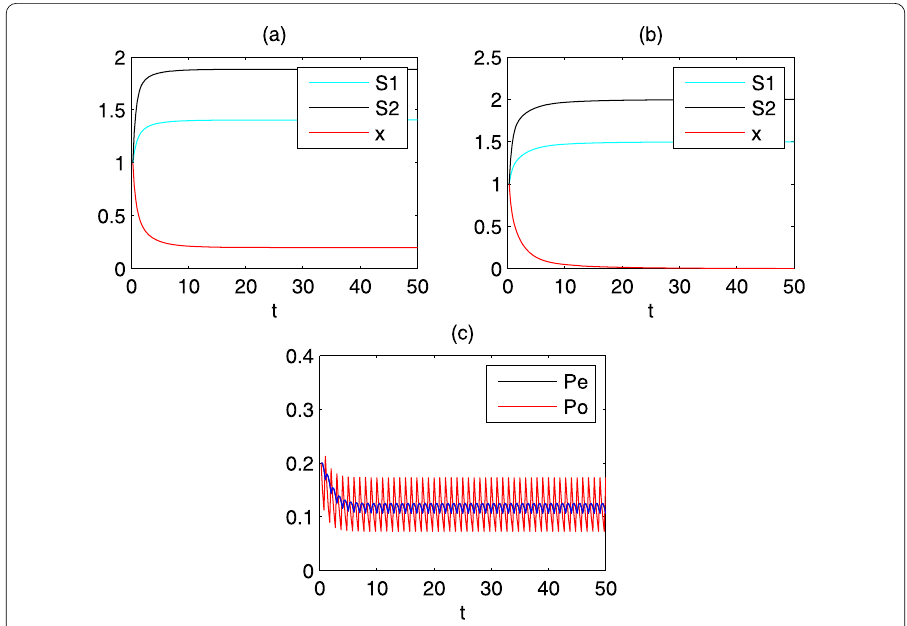
Figure 1 Time evolutions of the deterministic system with parameters S 10 = 1.5, S 20 = 2, Q = 1.45, δ 1 = 0.9, δ 2 = 1, a 1 = 1.6, a 2 = 1.6, μ 1 = 0.8, μ 2 = 0.8, r = 0.1, k = 1, g = 0.8, h = 1, m = 0.2, T = 1. ( a ) Time series for S 1 ( t ), S 2 ( t ), x ( t ) with parameters u = 0.1, R 2 = 1.1473. ( b ) Time series for S 1 ( t ), S 2 ( t ), x ( t ) with parameters u = 3.1, R 1 = 0.9944. ( c ) Time series for P 0 ( t ) and P e ( t